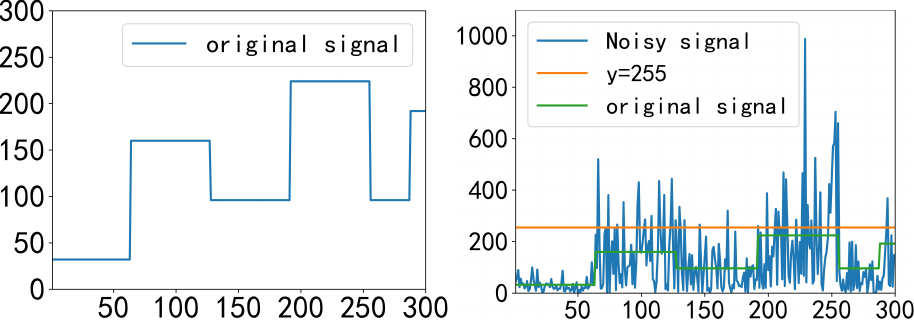
Figure 1. Original signal and noisy signal ( K =